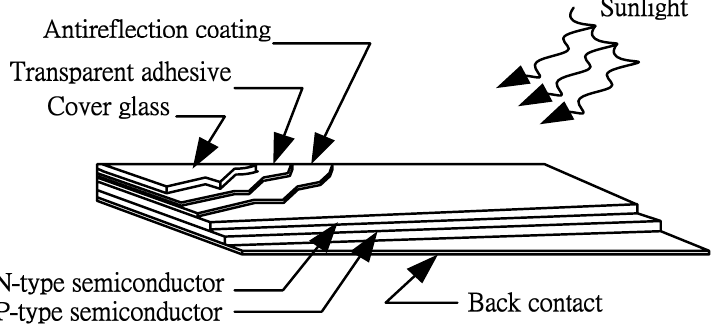
Figure 1. The working principle of a solar cell [1].